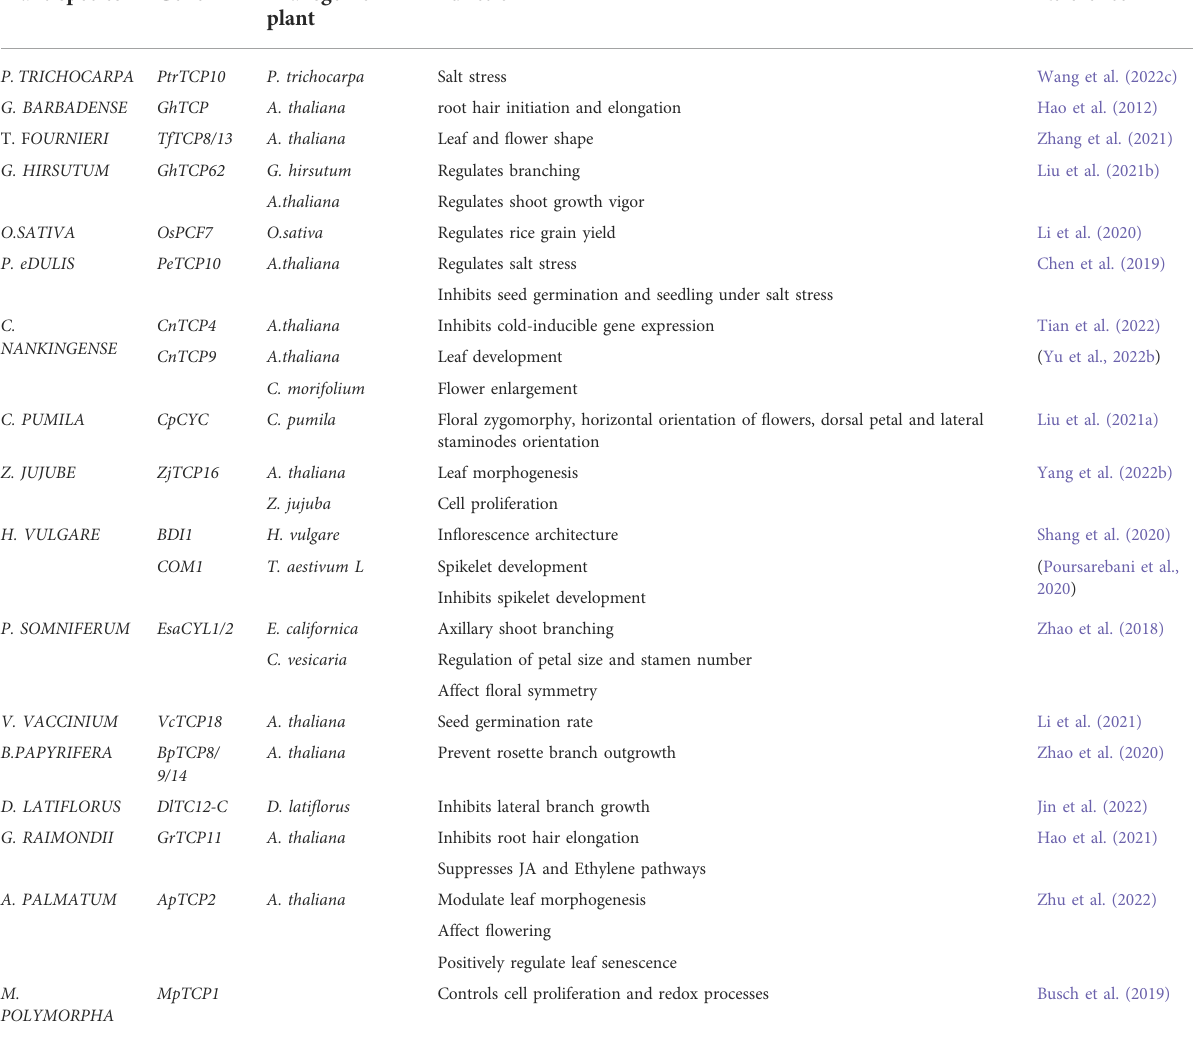
TABLE 1 Summary of some genes and their biological